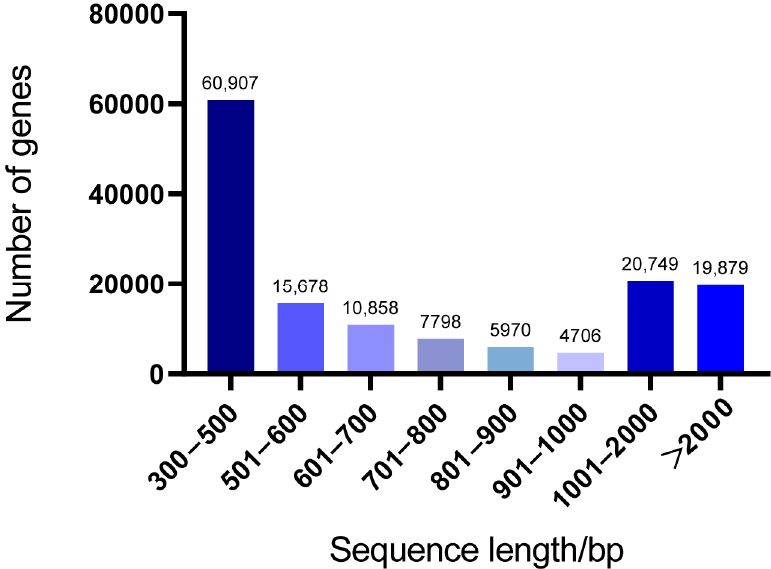
Figure 1. Distribution of unigene length of the transcriptome in the gonads of Macrobrachium rosenbergii . The darker the color, the larger the number.